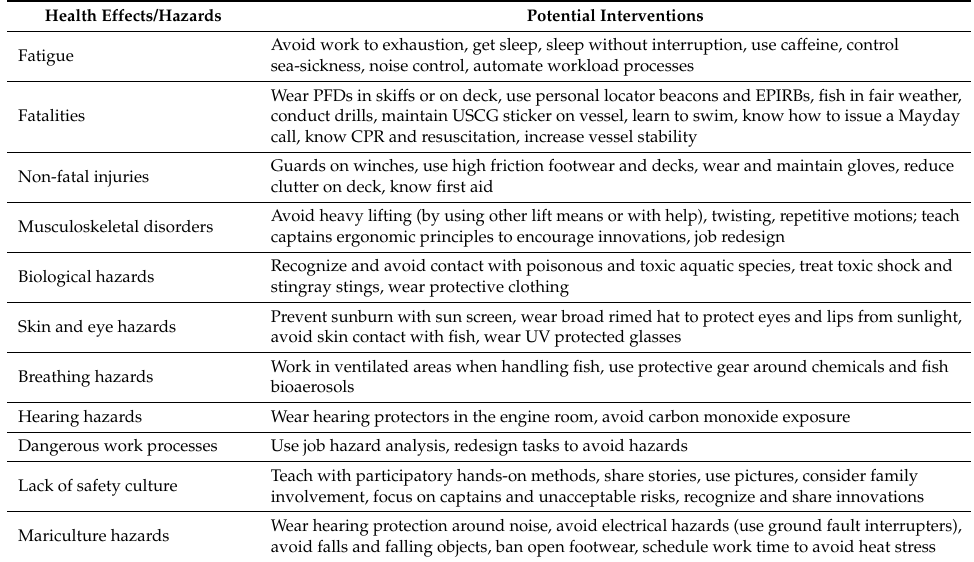
Table 5. Summary of potential interventions to prevent injuries, disabilities and diseases experienced by fishers in the Gulf of